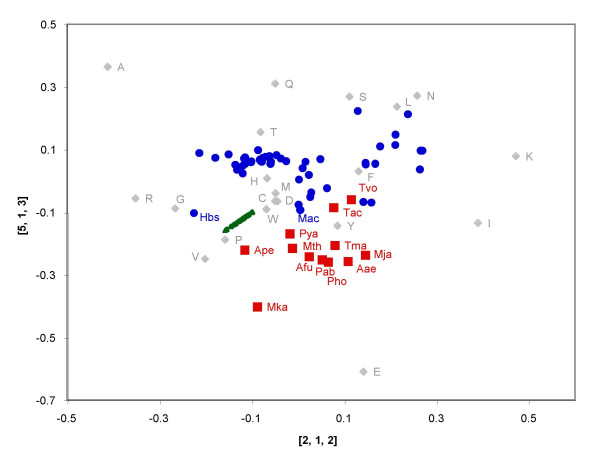
Triplot of [2, 1, 2] and [5, 1, 3] factors. Superimposed plot of the [2, 1, 2] and [5, 1, 3] factors showing the amino acid usage variability related to organisms. The red squares and blue circles represent thermophile and non-thermophile organisms, respectively. The green triangles represent the loadings matrix related to protein function. The abbreviations used in this figure are: Hbs, Halobacterium sp; Ape, Aeropyrum pernix; Mka, Methanopyrus kandleri; Mac, Methanosarcina acetivorans; Pya, Pyrobaculum aerophilum; Mth, Methanobacterium thermoautotrophicum; Afu, Archaeoglobus fulgidus; Pab, Pyrococcus abyssi; Pho, Pyrococcus horikoshii; Mja, Methanococcus jannaschii; Aae, Aquifex aeolicus; Tma, Thermotoga maritima; Tac, Thermoplasma acidophilum and Tvo, Thermoplasma volcanicum.